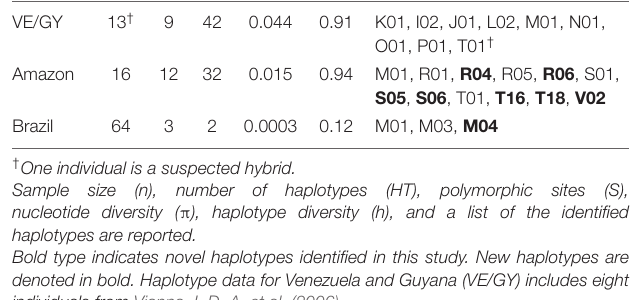
TABLE 4 | Amazonian and Antillean manatee control region mitochondrial DNA parameters for the three genetically identified clusters. Location n HT h List of haplotypes